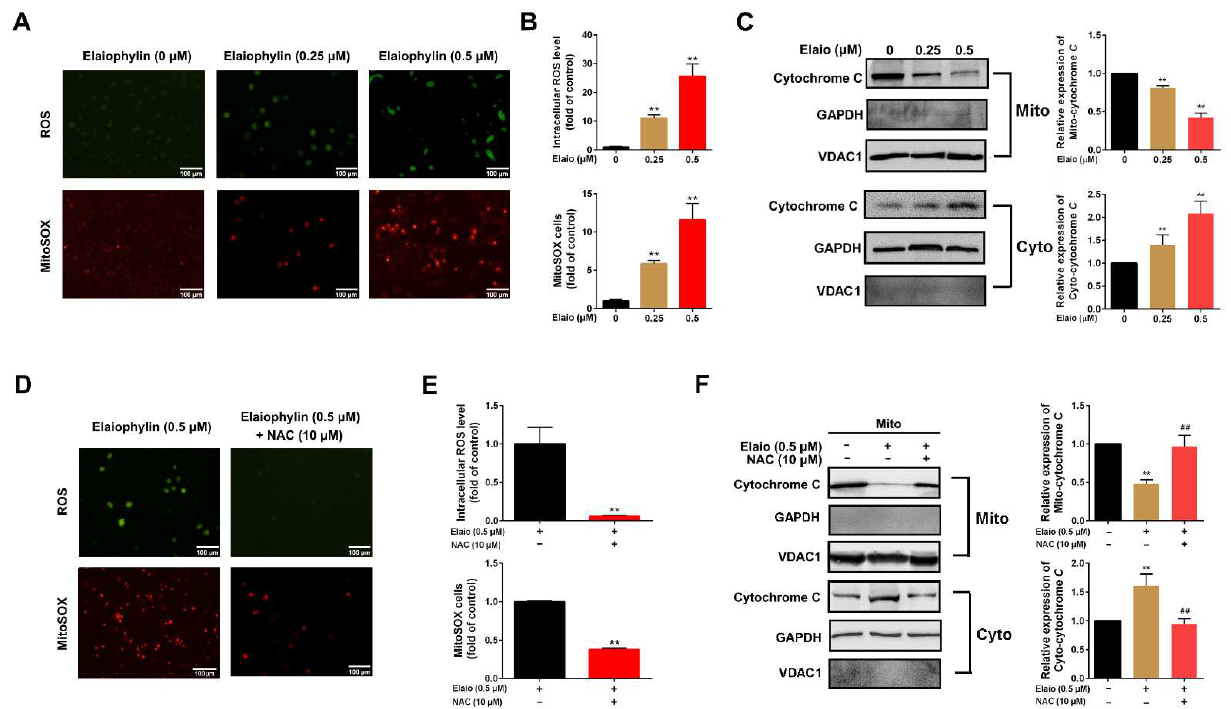
Figure 2. Elaiophylin induces intracellular and mitochondrial ROS in A549 cells. A549 cells were exposed to elaiophylin for 3 h with or without pre-treatment with NAC (10 µM) for 6 h. ( A , B , D , E ) Intracellular ROS level detection was assessed using DCFH-DA fluorescence probe; while mitochondrial ROS level detection was assessed using Mitosox red mitochondrial superoxide probe. ( C , F ) Cytochrome C translocation was determined by Western blot analysis. GAPDH and VADC1 were used as reference proteins in cytoplasm and mitochondria, respectively. Data were expressed as means ± SD of three experiments and each experiment included triplicated repeats. * p < 0.05, ** p < 0.01 vs. control, ## p < 0.01 vs. Elaiophylin group. Original Western Blots can be found at Supplementary